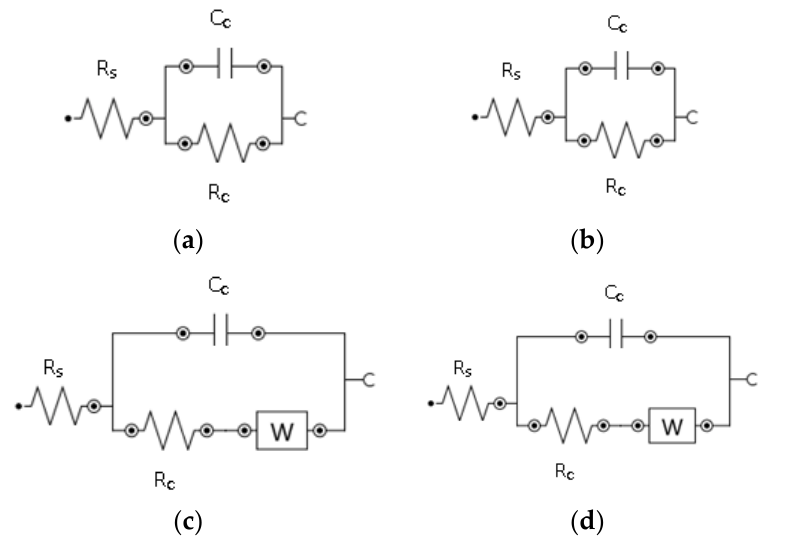
Figure 11. EEC of virgin and aged samples. ( a ) Reference ( b ) Experiment 1 ( c ) Experiment 2 ( d ) Experiment 3. Table 7. EEC values for virgin and aged samples.